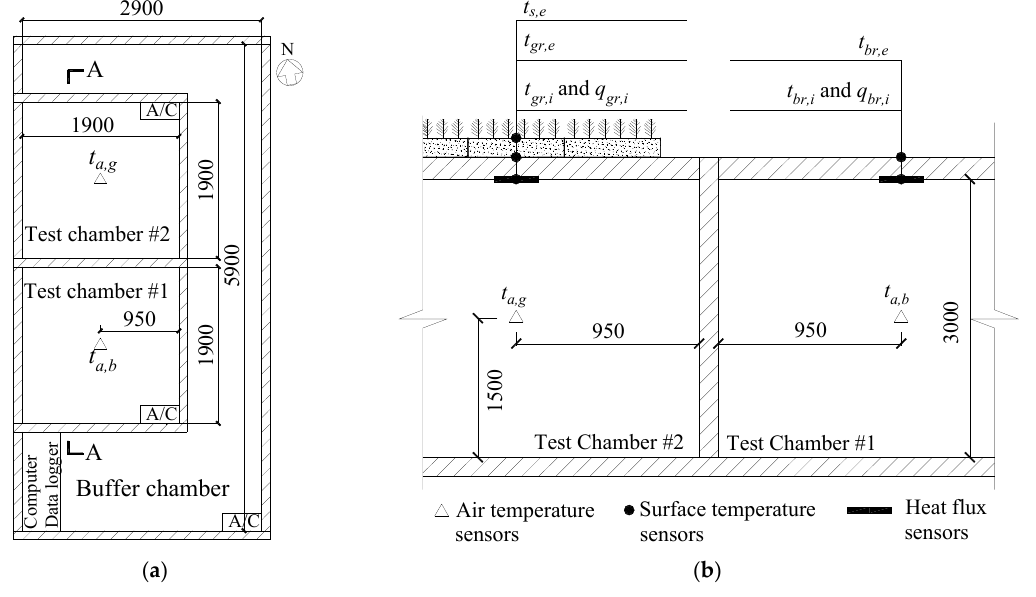
Figure 1. Schematics of the experimental system and measuring points (unit: mm). ( a ) Plan drawing; ( b ) A–A cross-section drawing. Here, t a,b : air temperature of the chamber under a bare roof; t a,g : air temperature of the chamber under the green roof; t br,e and t br,i : external and internal surface temperatures of the bare roof; t s,e , t gr,e , and t gr,i : external surface temperature of the substrate, external surface temperature of the green roof, and internal surface temperature of the green roof; q br,i : internal surface heat flux of the bare roof; q gr,i : internal surface heat flux of the green roof.